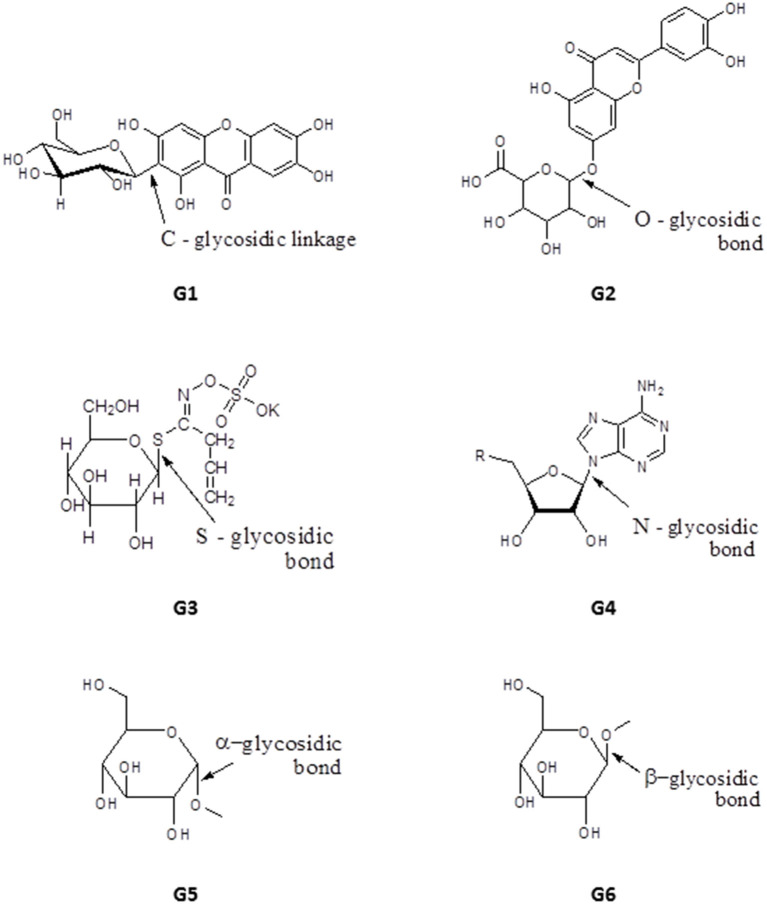
Structure of basic skeleton of glycoside sub-groups showing different glycosidic bonds.